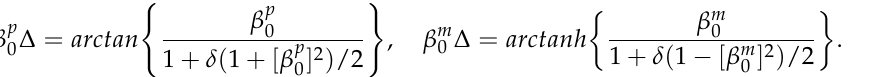
and − β p as function of ( a ) Pe y (depending on δ ) and ( b ) δ (depending on 0 0 from − β p 0 0